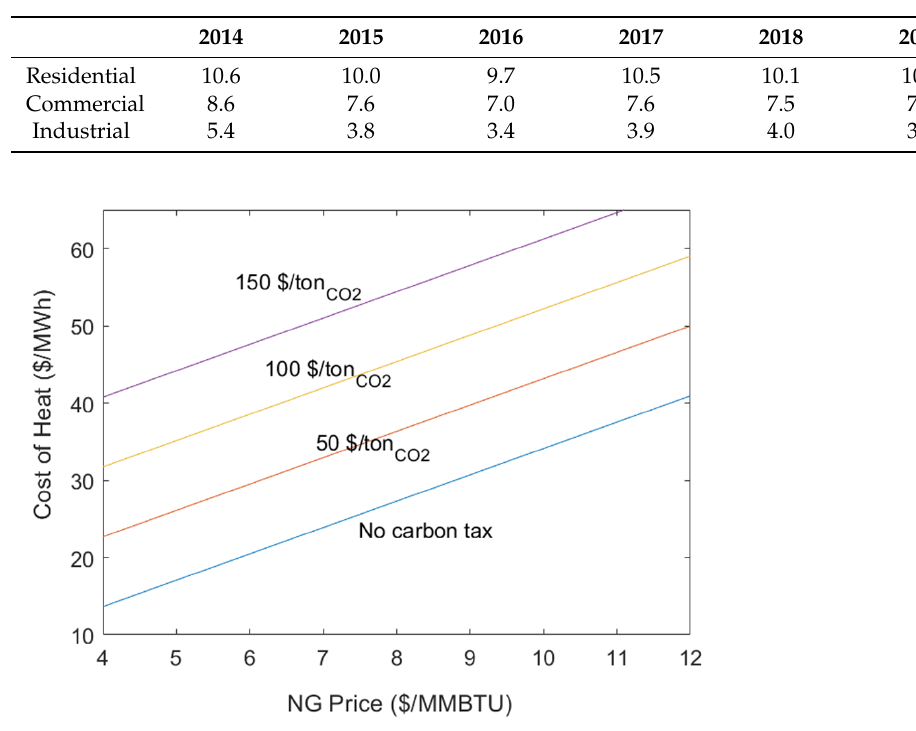
Table 2. Average natural gas (NG) prices in the U.S. (USD/MMBTU) (Source EIA).